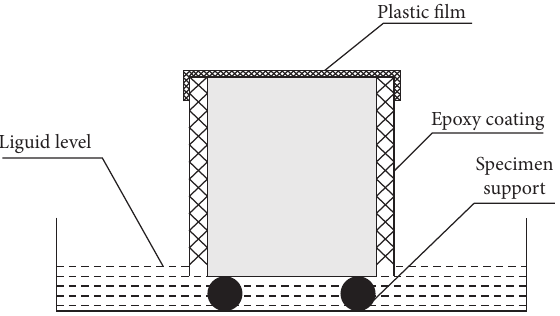
Figure 1: Capillary water absorption device diagram. Table 5: Times and tolerances for the measurements